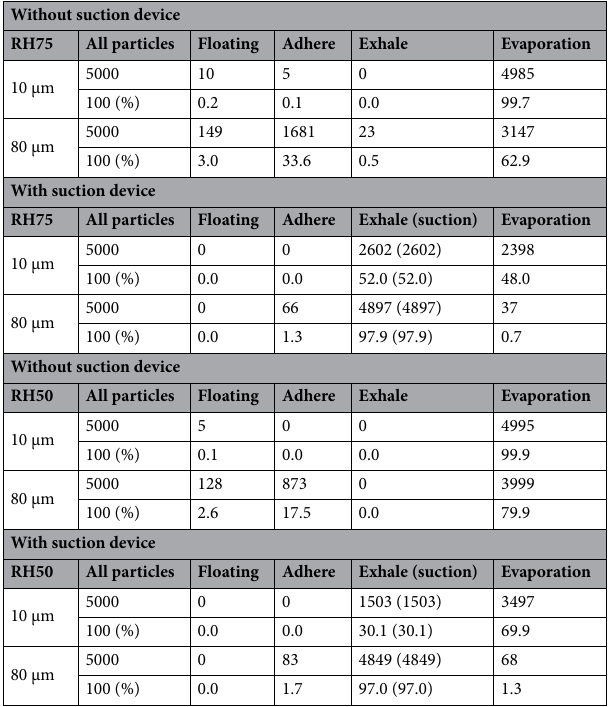
Table 2. The relative proportions of suspended, deposited, exhaled, and suctioned particles in the presence and absence of a suction device positioned as shown in Fig. 2, 100 s after the patient begins exhaling at a constant rate of 2.5 m/s (Case X) and assuming 75% relative humidity (RH75) and 50% (RH50). “Evaporation” corresponds to the number of particles that evaporated before they were removed from the room or deposited on the